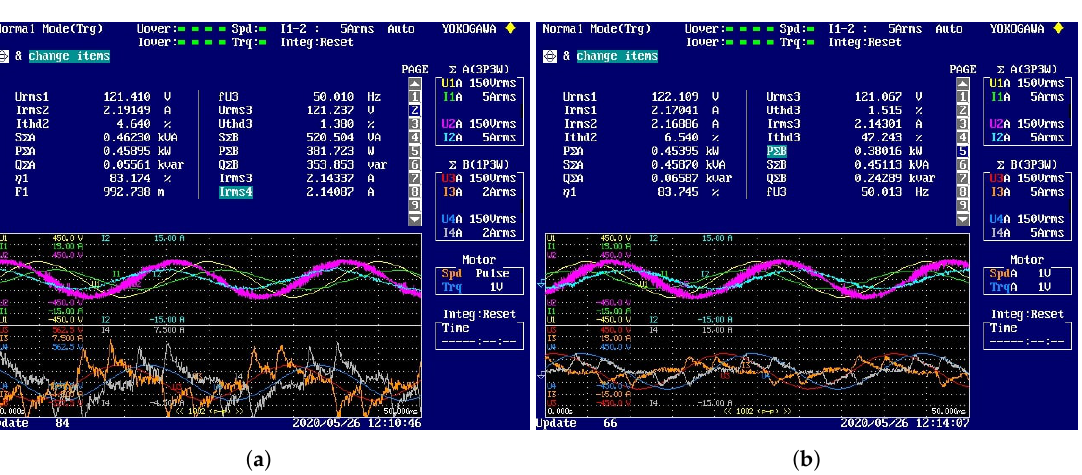
Figure 12. Power analyzer results when the systems are equally sharing the non-linear load: ( a ) UPS1 providing 50% of the load power; ( b ) UPS2 providing 50% of the load